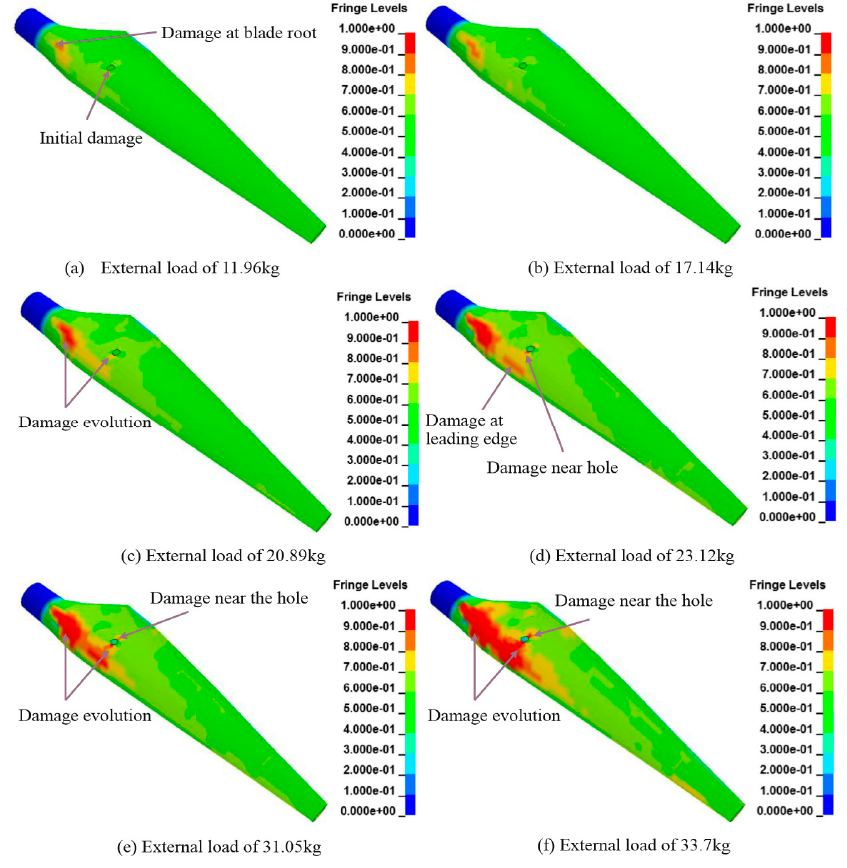
Figure 8. Damage of the matrix for composite wind turbine blade [64].